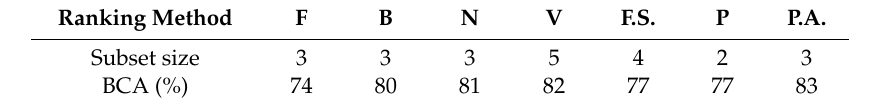
Table 6. Ranking methods performance comparison on the Diabetes dataset using Logistic regression.